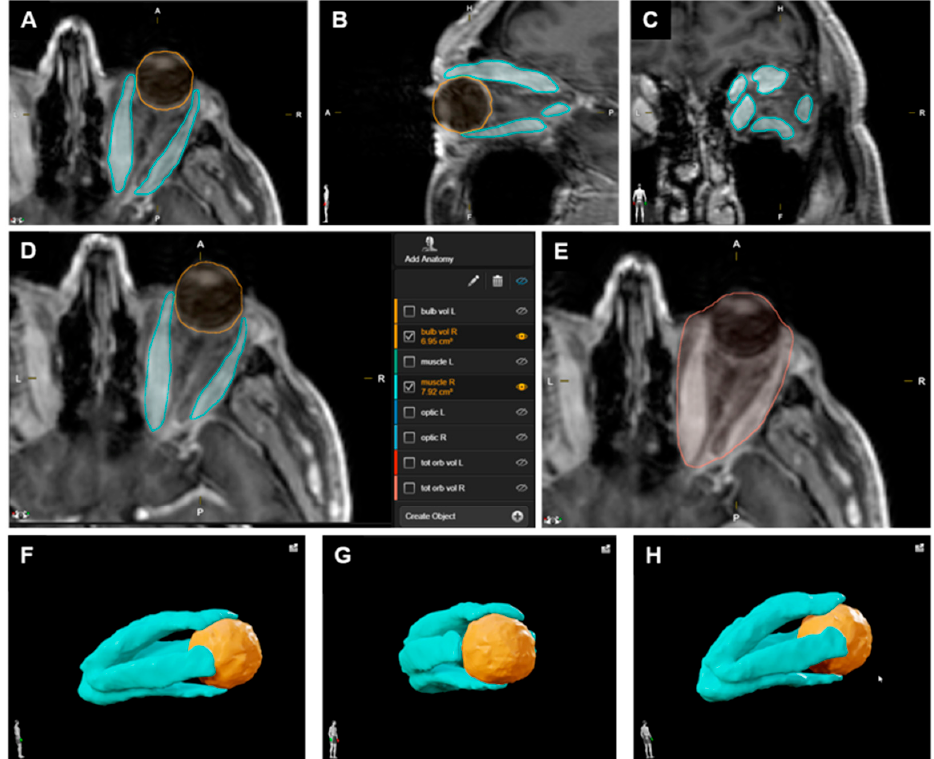
Figure 1. Illustration of the semi-automatic volumetry technique. ( A – C ): Volumetric analysis of the orbital content (right orbit) in a patient affected by Graves’ orbitopathy (GO) (not-increased orbital muscle volume) prior to decompressive surgery, with orbital extraocular muscles marked in blue and eye bulb in orange in an axial ( A ), sagittal ( B ) and coronal ( C ) view. ( D ): Absolute volumetric values (in cm 3 ) provided by the system after three-dimensional (3D) analysis of the structures of interest (for example eye bulb with 6.95 cm 3 and muscle with 7.92 cm 3 ). ( E ): Volumetric analysis of the whole orbital content (marked in red in an axial view) for subsequent calculation of the orbital muscle fraction in relation to the total orbital volume. ( G , H ): 3D view of the volume-analyzed structures (orbital extraocular muscles marked in blue and eye bulb in orange), shown from different perspectives: lateral right ( F ), anterior oblique right ( G ), and posterior oblique right ( H